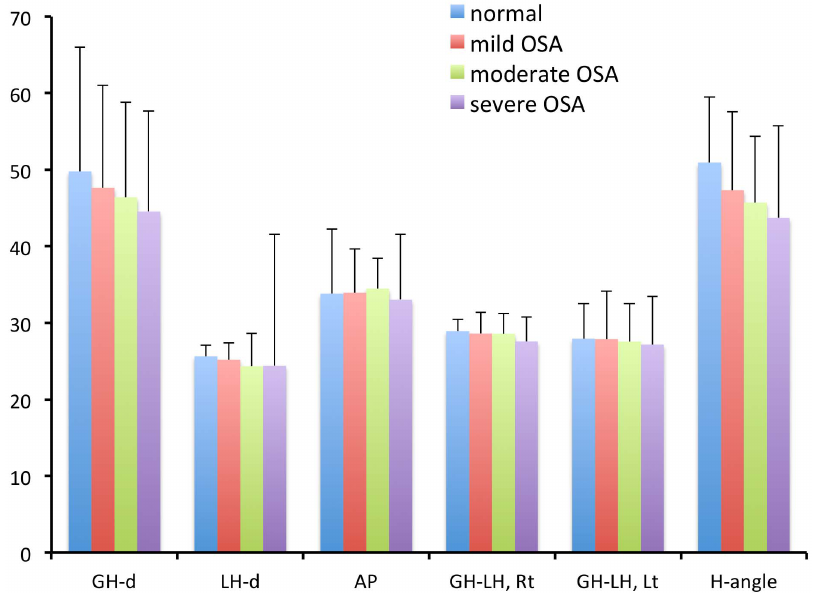
Figure 2. Comparison of hyoid bone parameter values in four groups of patients with sleep apnea. doi:10.1371/journal.pone.0081590.g002 Table 1. A shorter or narrower GH-d or H-angle indicated a tendency toward more severe OSA (Figure 2).